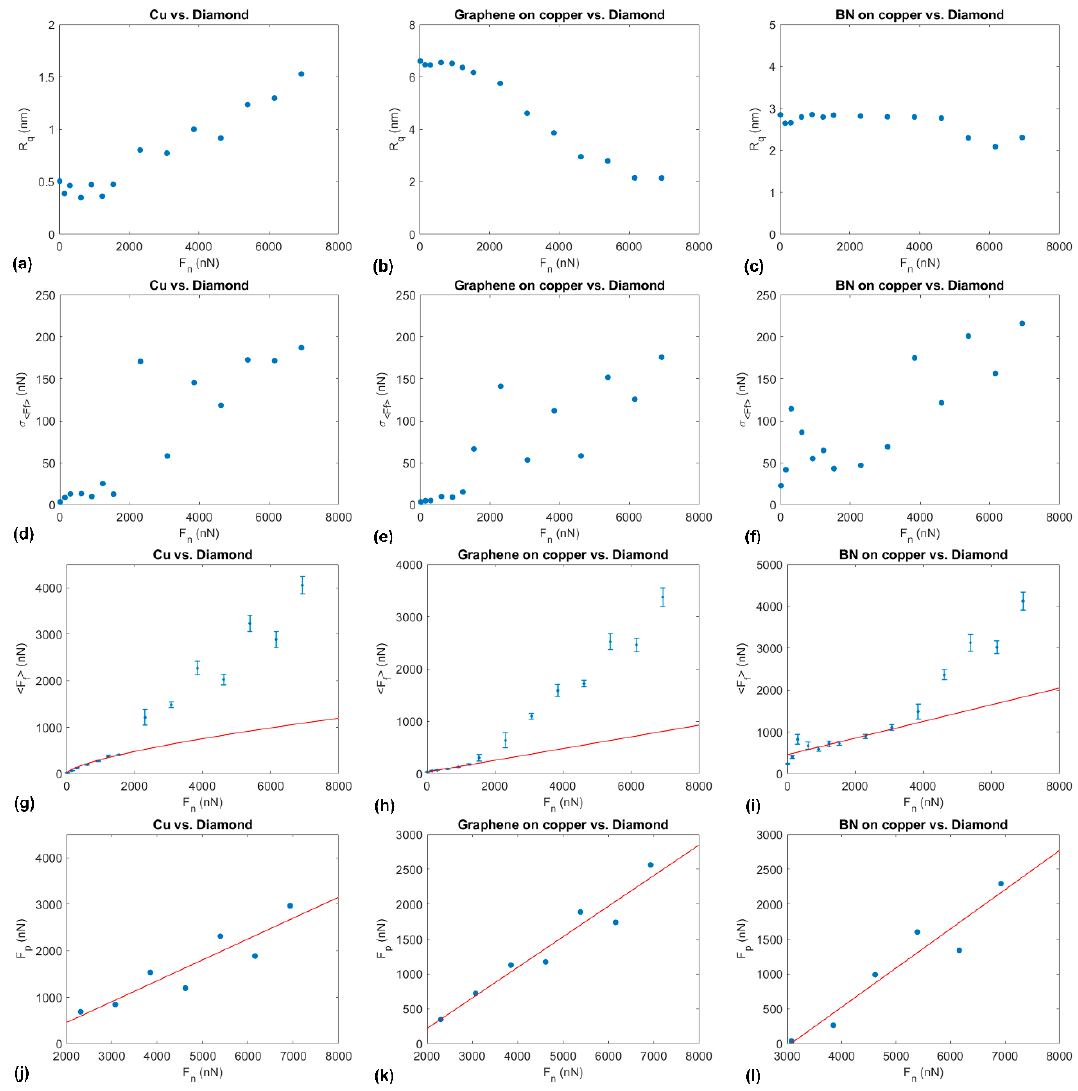
Figure 7. Evolution of ( a – c ) R q , (d–f) σ <Ff> , ( g – i ) <F f > , and ( j – l ) F p as a function of F n for ( a , d , g , j ) annealed copper, ( b , e , h , k ) graphene-coated copper, and ( c , f ,i,l) BN-coated copper. In ( g ), the solid red line illustrates the JKR fit function, while the solid red lines in ( h – l ) represent linear fit functions.